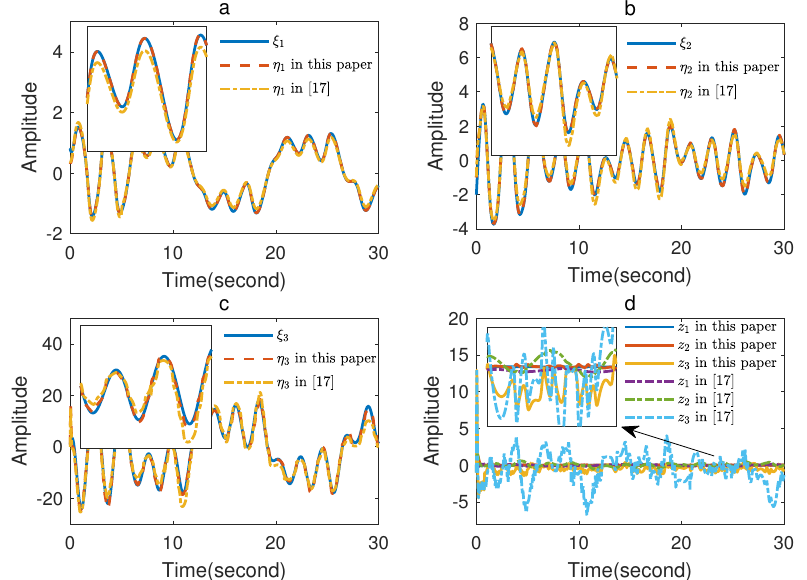
Figure 2. Simulation results between the proposed method and the control method in [17]. ( a ) System states ξ 1 and η 1 . ( b ) System states ξ 2 and η 2 . ( c ) System states ξ 3 and η 3 . ( d ) Synchronization errors z 1 , z 2 , and z 3 under the methods used in this paper and in [17].